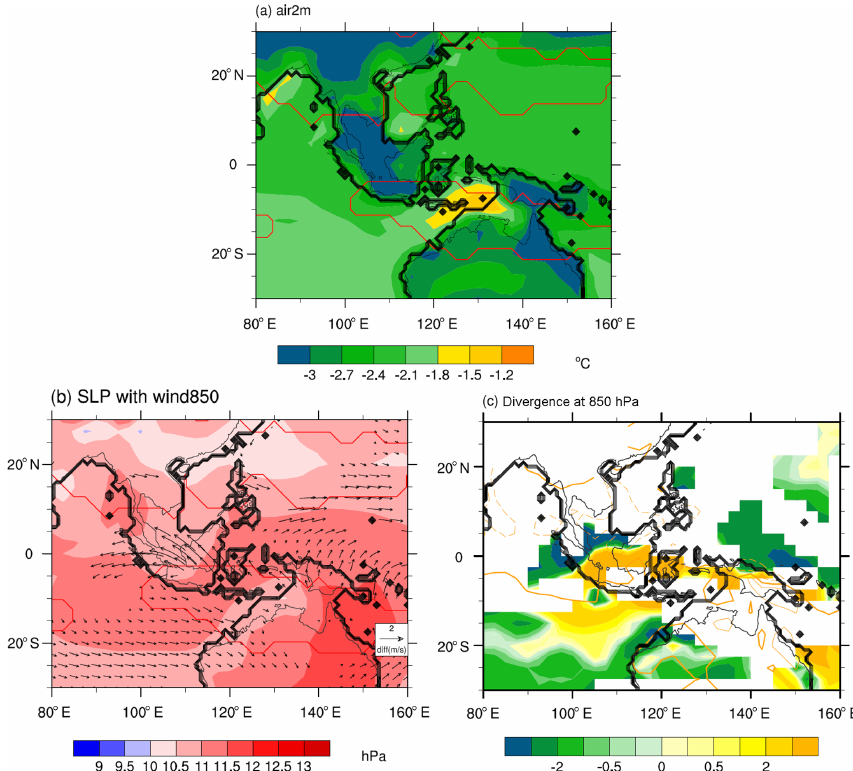
Figure 5. JJA mean (a) surface air temperature, (b) sea level pressure (shading) with 850hPa wind (vector), and (c) 850hPa divergence differences between LGME and piControl. The red lines in (a) and (b) enclose the monsoon domains. The orange lines in (c) represent the climatology derived from piControl. The thick black lines denote the coastal lines in LGME provided by CMIP5–PMIP3, and the thin black lines denote the coastal lines in piControl. Only those areas where the signal-to-noise ratio exceeds 1 are plotted.